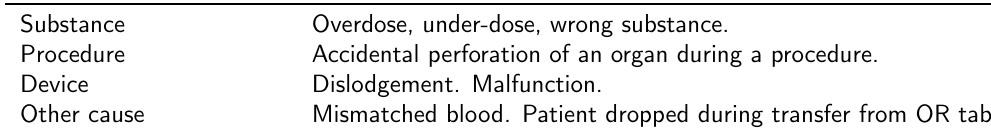
Table 1 - Examples of corresponding Q&S Mode or Mechanism Cause or Source of Harm Mode or